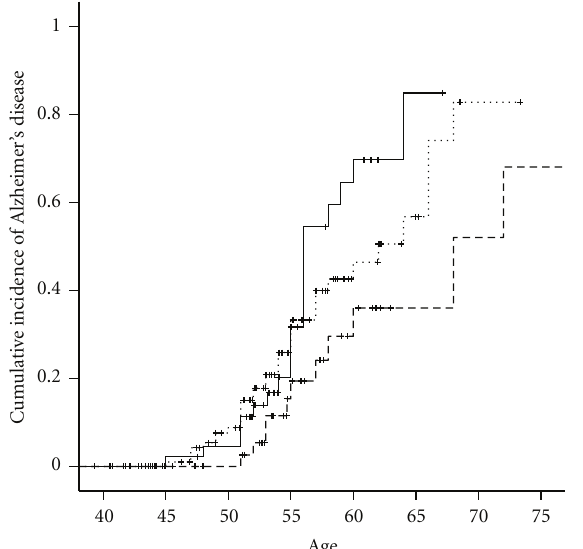
Figure 1: Cumulative incidence of Alzheimer’s disease by HSD17B1 rs605059 genotype in women with Down syndrome. TT - - - -.